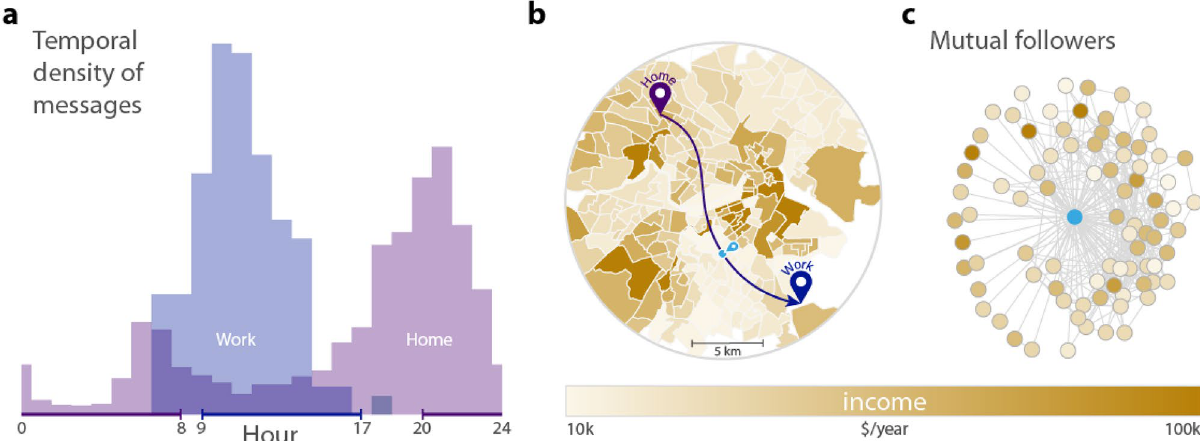
Figure 1. Combination of spatial, temporal and social network data of geolocated Twitter messages. ( a ) Home and work locations of users are identified through the distribution of timestamps on all their collected tweets within their most frequently visited spatial clusters. We assign a possible home location (8 p.m.–8 a.m.) and a possible work location (9 a.m.–5 p.m.) to each user 45,46 as their most frequently visited location in the given period. The histogram represents the timeline of tweets for the clusters of a sample user. ( b ) Commuting is defined as the overhead distance between users’ home and work locations. The colorbar of the map indicates the income level of census tracts. Census tract shapes have been downloaded from https:// www. census. gov/ data/ devel opers/ data- sets/ acs- 5year. html, the figure is the authors’ own creation using the geopandas library in Python ( geopandas version 0.6.1, https:// pypi. org/ proje ct/ geopa ndas/0. 6.1/, Python 3.7.2). ( c ) Twitter ego network of a sample user based on mutual followership. The coloring of nodes also corresponds to the level of income in the home tract of